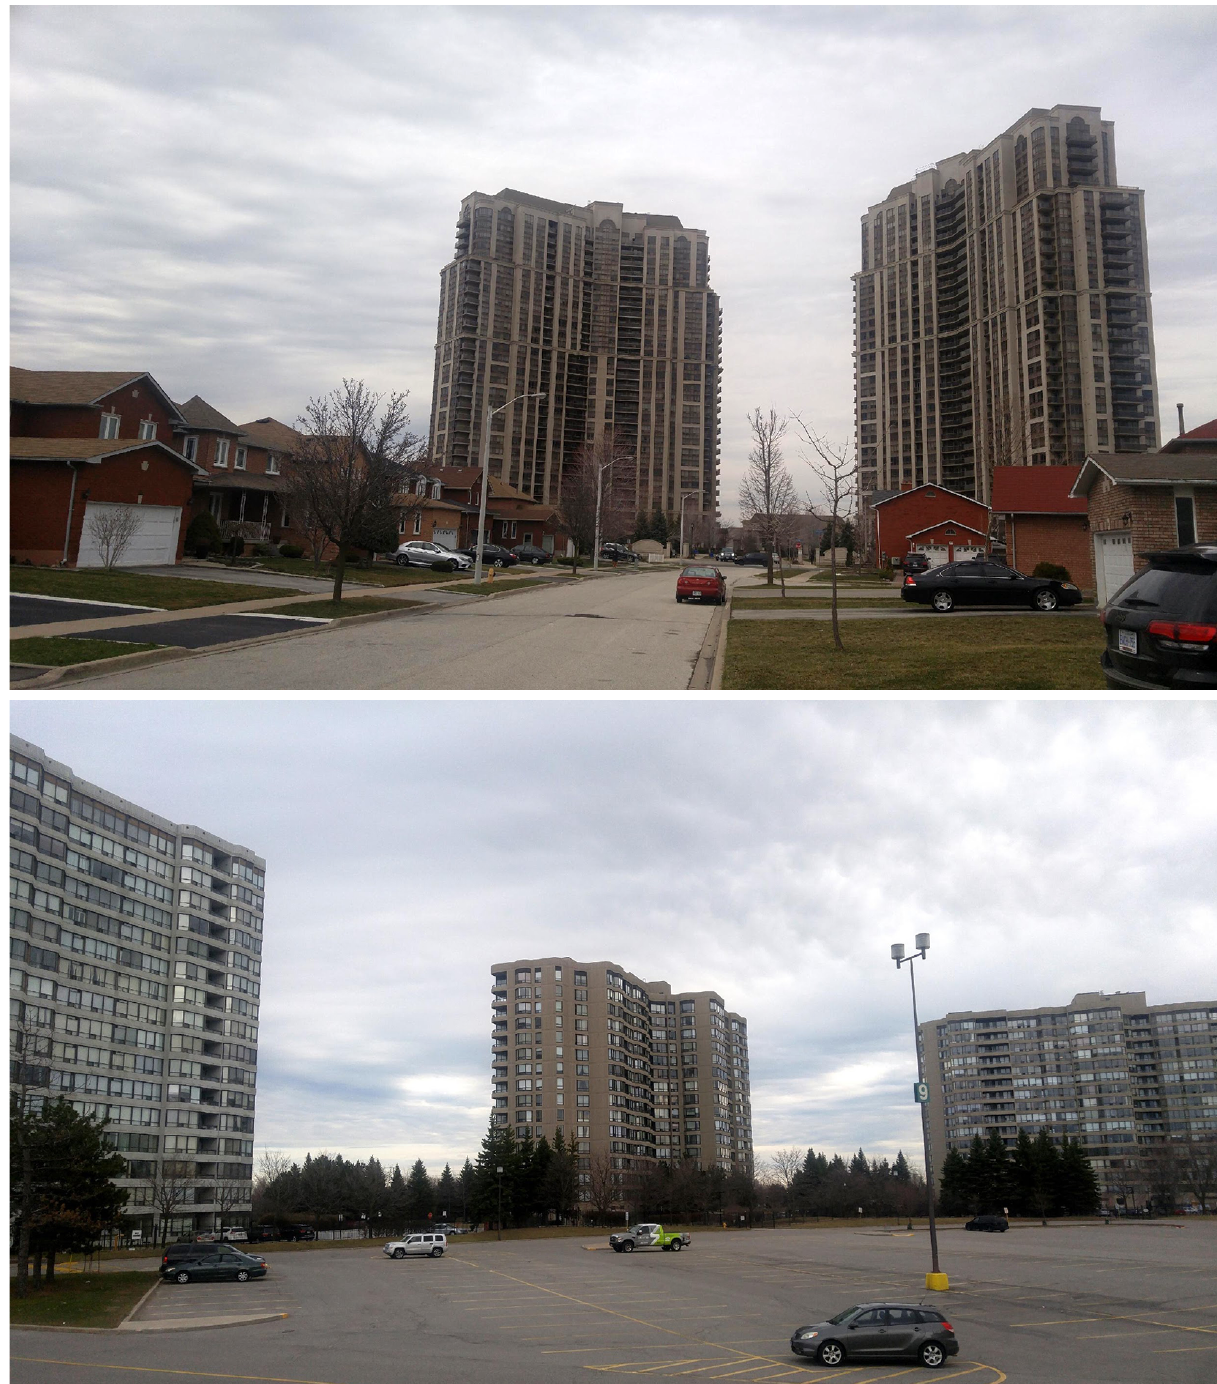
Figure 1. High-rise apartments in Toronto’s suburban